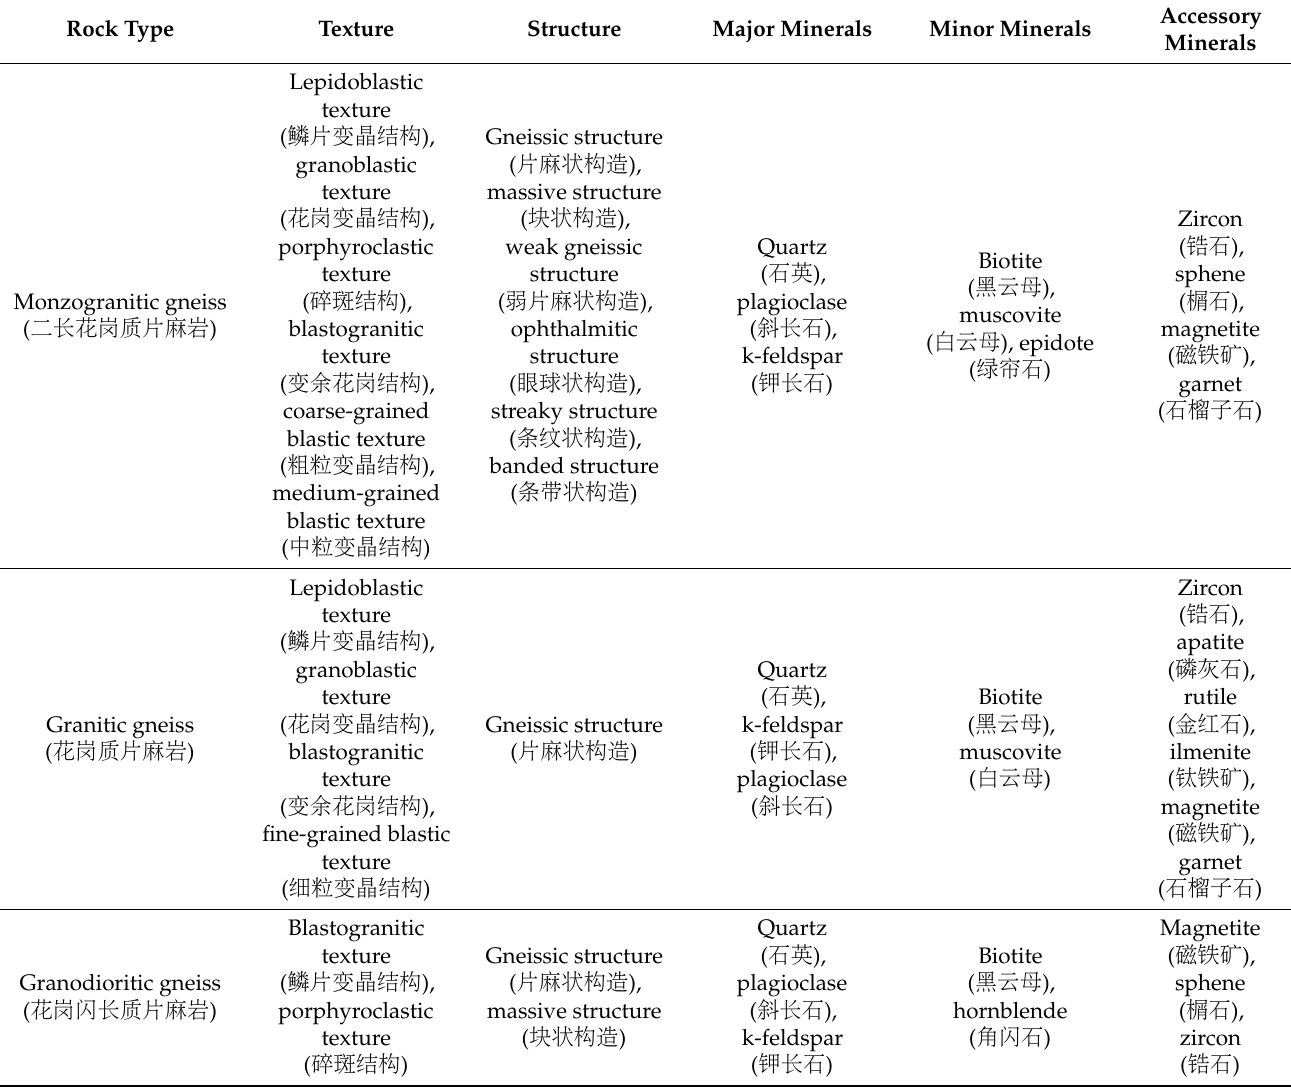
Table 1. Prior knowledge of the metamorphic plutonic rocks in the Fengxiangyi